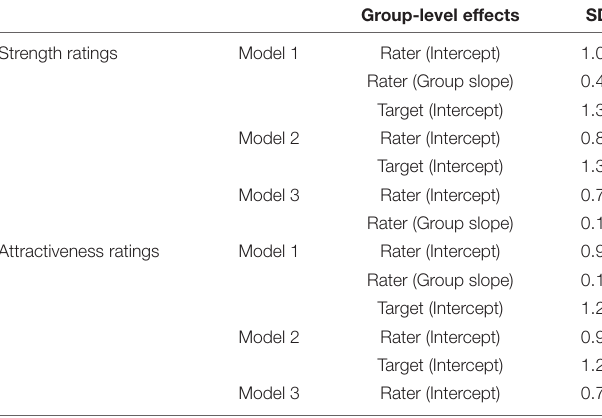
TABLE 6 | Standard deviation of raters’ and targets’ random effects.